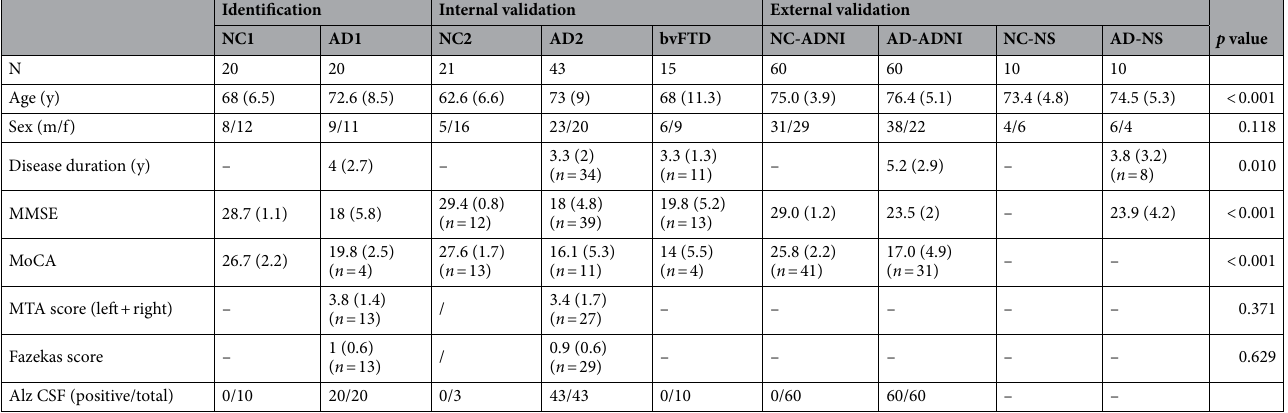
Table 1. Demographic and clinical data in identification and validation groups. Data is presented as mean (SD). Positive Alzheimer (Alz) CSF was defined as A+/T+/N+ or A+/T+/N− (cut-offs: Aβ 42 < 650 pg/ml or Aβ 42 /Aβ 40 < 0.077, p-tau > 60 pg/ml, t-tau > 400 pg/ml) for identification and internal validation groups and as A+/T+/N+ or A+/T+/N− (cut-offs: Aβ 42 < 880 pg/ml or Aβ 42 /Aβ 40 < 0.077, p-tau > 21.8 pg/ml and t-tau > 245 pg/ml) for ADNI cohort. NC normal control, AD Alzheimer’s dementia, bvFTD behavioral variant of frontotemporal dementia, NS Northshore, ADNI Alzheimer’s Disease Neuroimaging Initiative, MMSE